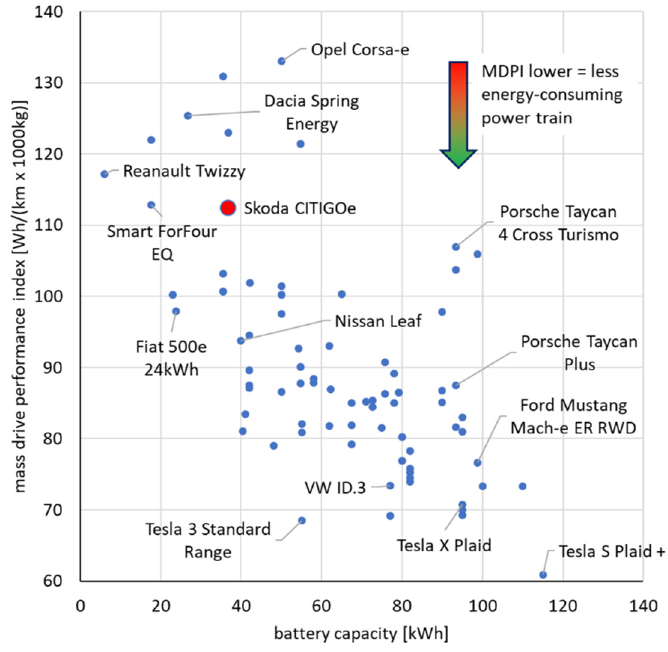
Figure 6. Mass drive performance index of EV vehicles [35].